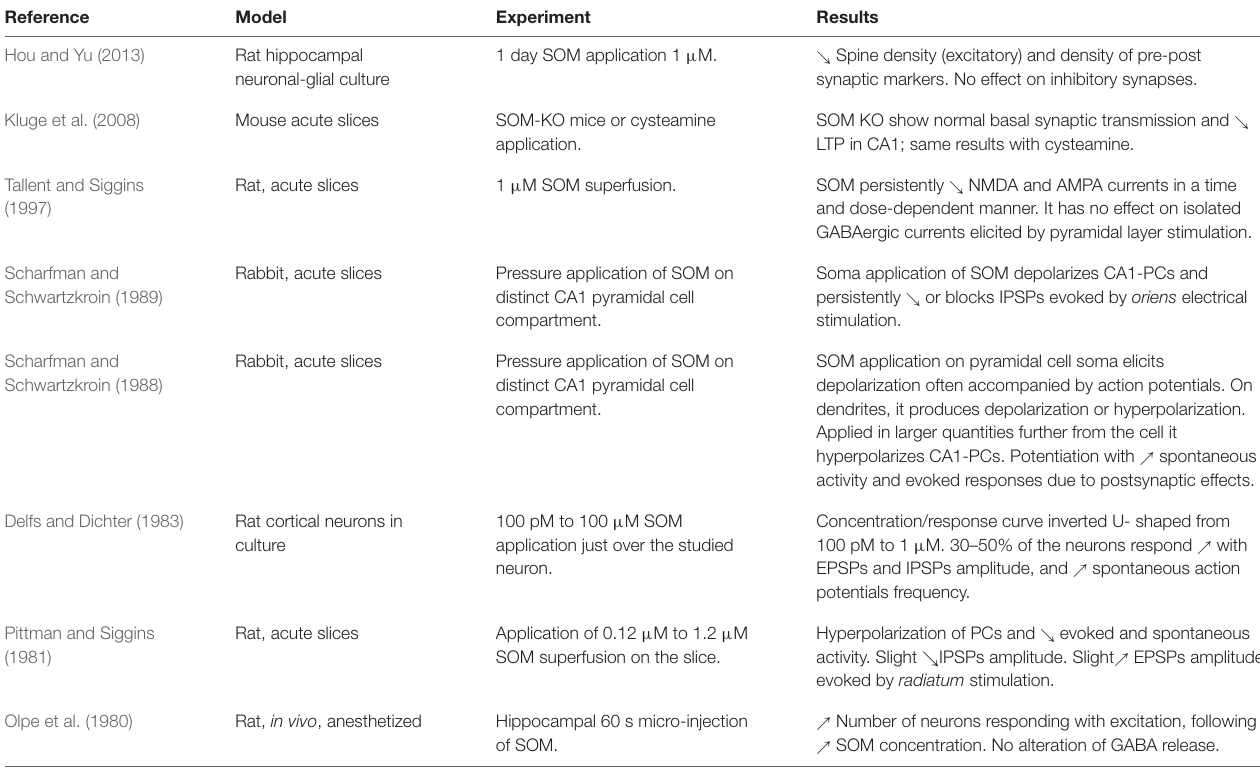
TABLE 1 | Effects of somatostatin (SOM) on hippocampal pyramidal cell